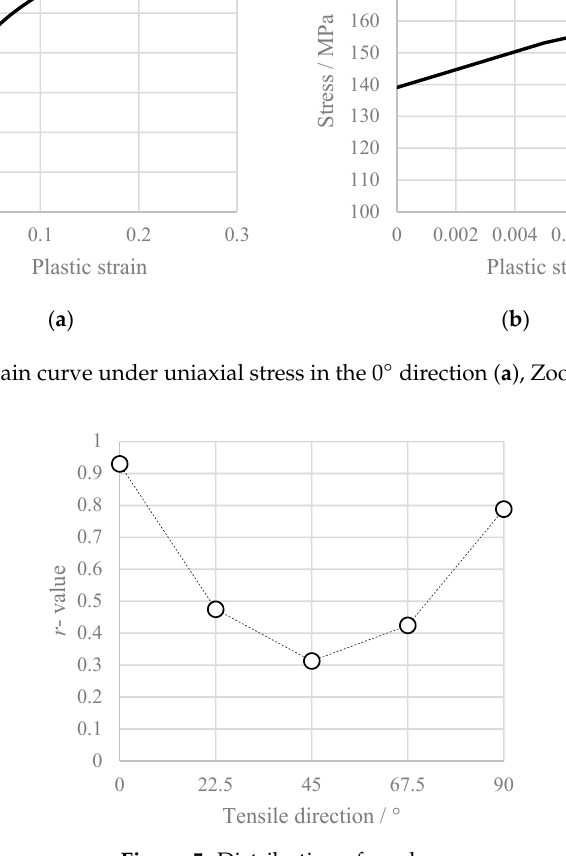
Figure 5. Distribution of r -value.